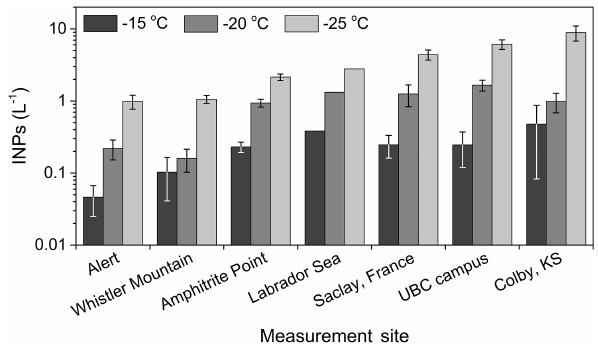
Figure 2. Mean INP number concentrations at droplet freezing tem- peratures of − 15 ◦ C (dark gray), − 20 ◦ C (intermediate gray), and − 25 ◦ C (light gray). Uncertainty is given as the standard error of the mean, assuming a normal distribution. As only one sample was available from the Labrador Sea, no uncertainty is